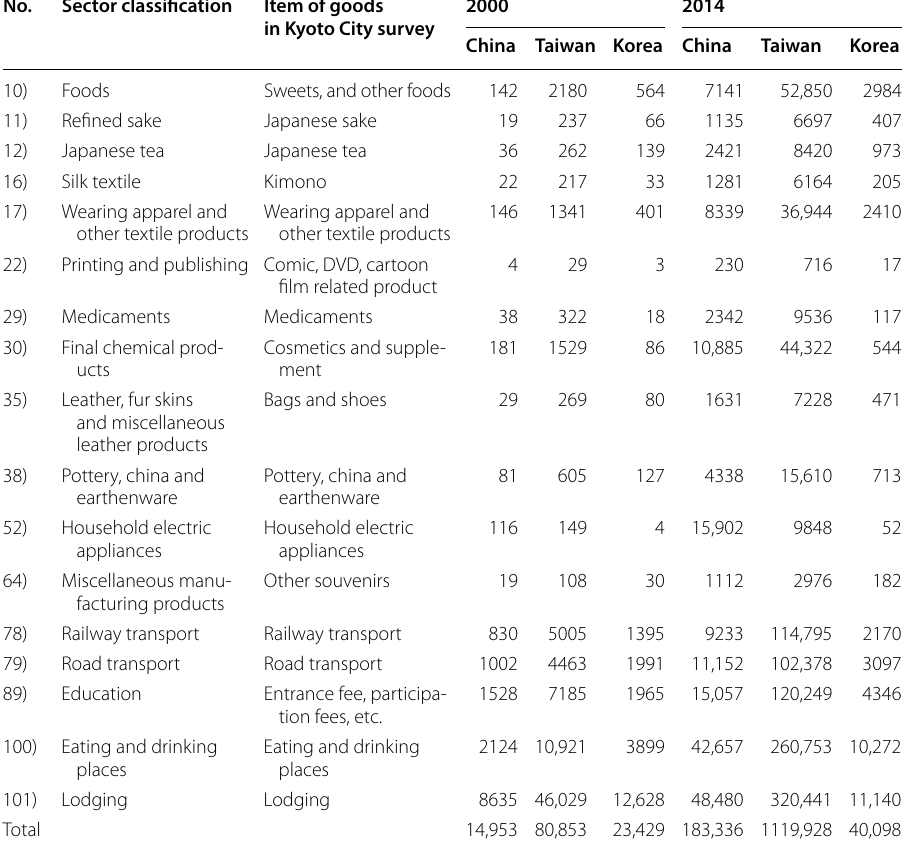
2014 prices adjusted to 2000 values